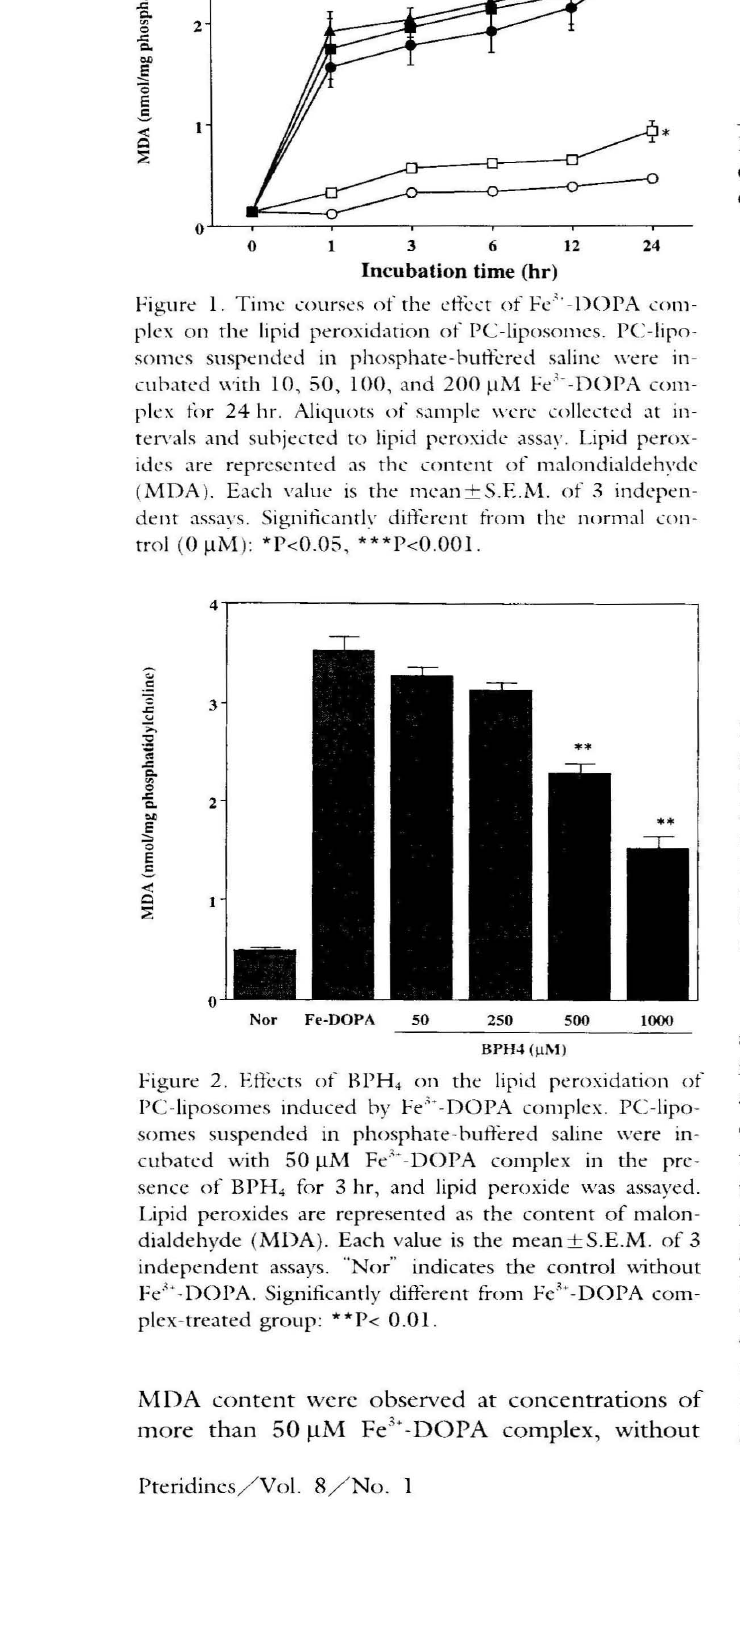
and other scaveng 4